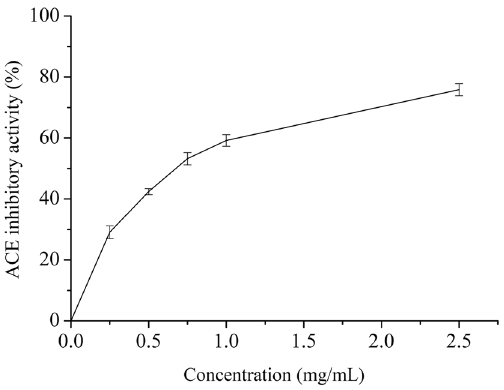
Figure 2. Angiotensin I-converting enzyme (ACE) inhibitory activity of WOP at different concentrations. The data are the average of triplicate experiments. Error bars show the standard